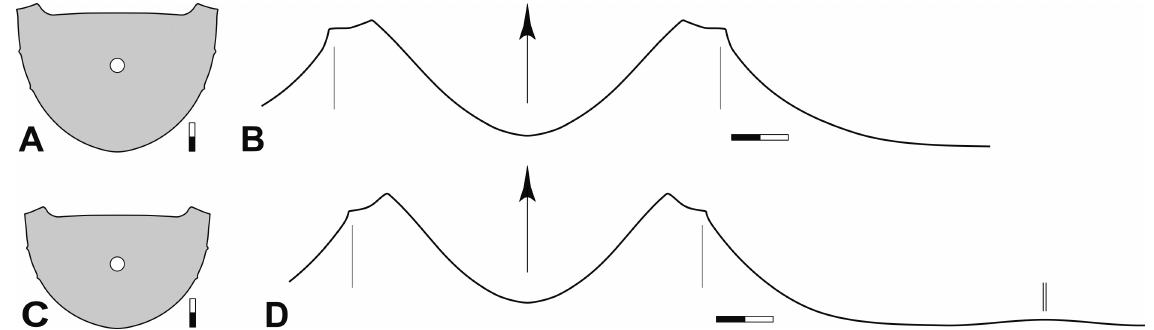
Fig. 15. Vestinautilus angulatus sp. nov. from Oued Temertasset (both Korn et al . 2002 Coll.). A . Whorl profile of paratype MB.C.30462.1. B . Suture line of paratype MB.C.30462.1, at ww = 14.1 mm, wh = 9.0 mm. C . Whorl profile of holotype MB.C.30461.1. D . Suture line of holotype MB.C.30461.1, at ww = 12.7 mm, wh = 8.8 mm. Scale bar units = 1 mm.